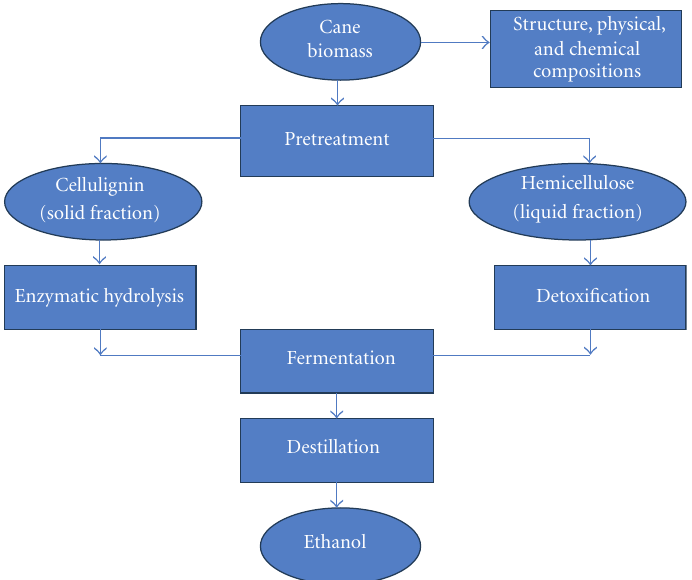
Figure 1: Procedural flow diagram for the bioconversion of cane biomass into 2G ethanol.